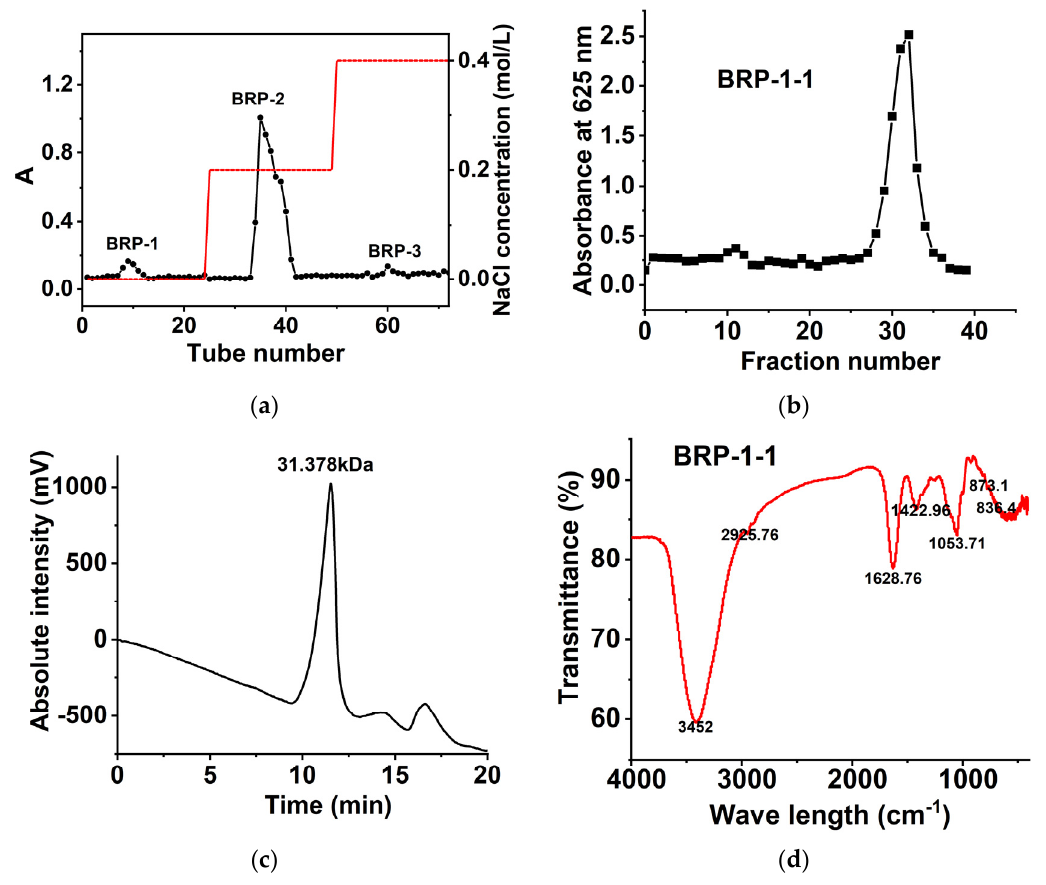
Figure 3. ( a ) Chromatogram of BRP on DEAE-650 column, ( b ) chromatogram of BRP-1 on Sephadex G-100 column; ( c ) the Mw distribution of BRP-1-1; ( d ) the FT-IR spectra of RPP-1-1.